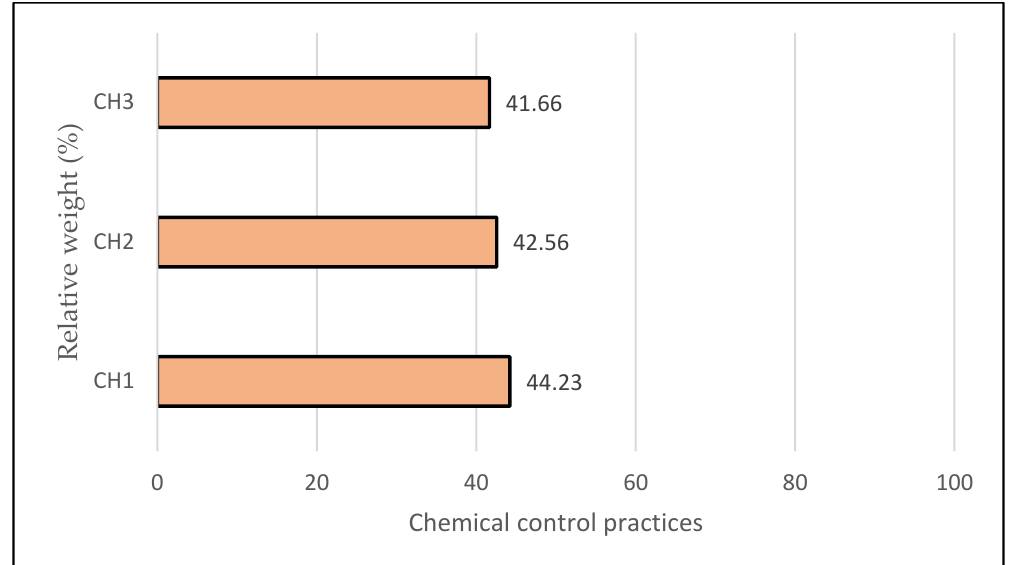
Figure 5. Farmers’ adoption of mechanical control practices for red palm weevil control. (M1 = cov- ering roots of small trees with soil to a height of 20 cm to prevent insect attacks, M2 = removing weeds and dry trunks and disposing of them in the recommended way, M3 = eradicating infested palms, M4 = removing infested or dead trees and the pruning products on neglected farms, M5 = closing all openings on the trunks of palms, M6 = scraping infested areas until healthy tissue is exposed).